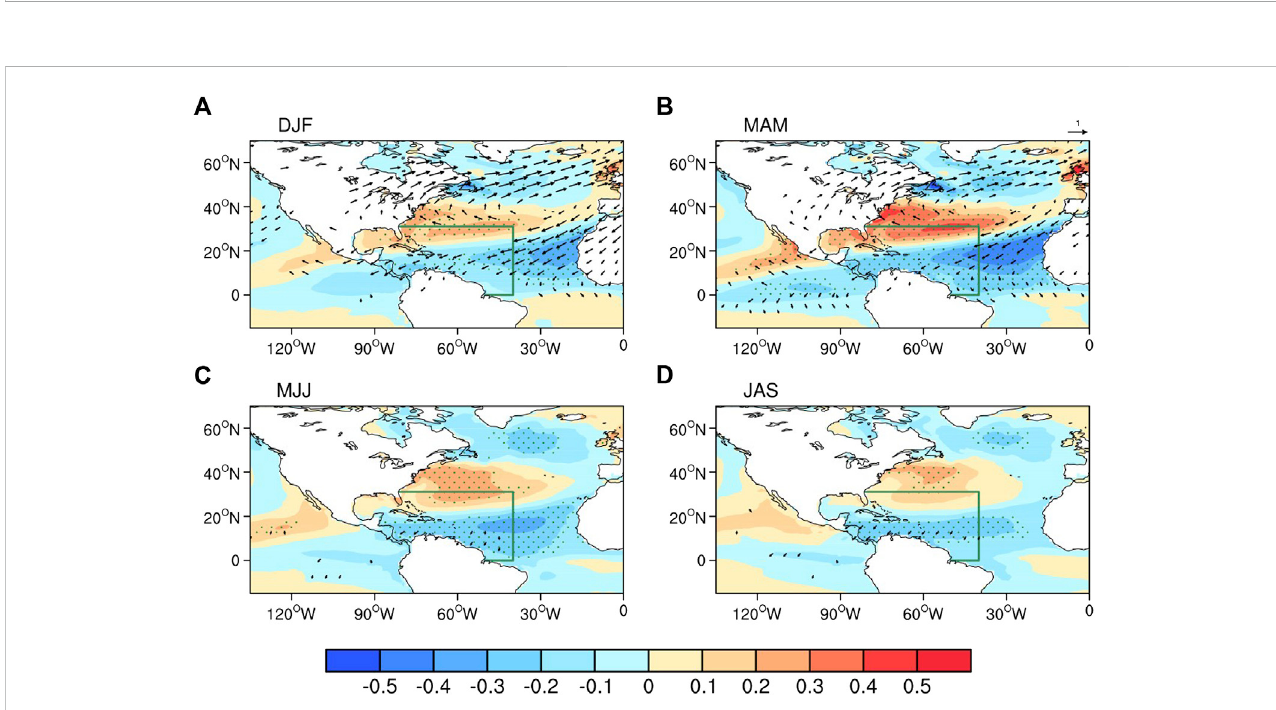
FIGURE 13 As in Figure 8 but for correlation maps of the 3-month averaged SST (shading, units: ° C) and surface winds (vectors, units: m\s) anomalies with the NADI derived from the MME of 25 CMIP6 model